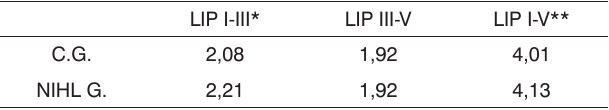
Table 7. Mean values of LIPI-III, LIPIII-V and LIPI-V of the left ear in both groups. LIP I-III* LIP III-V LIP